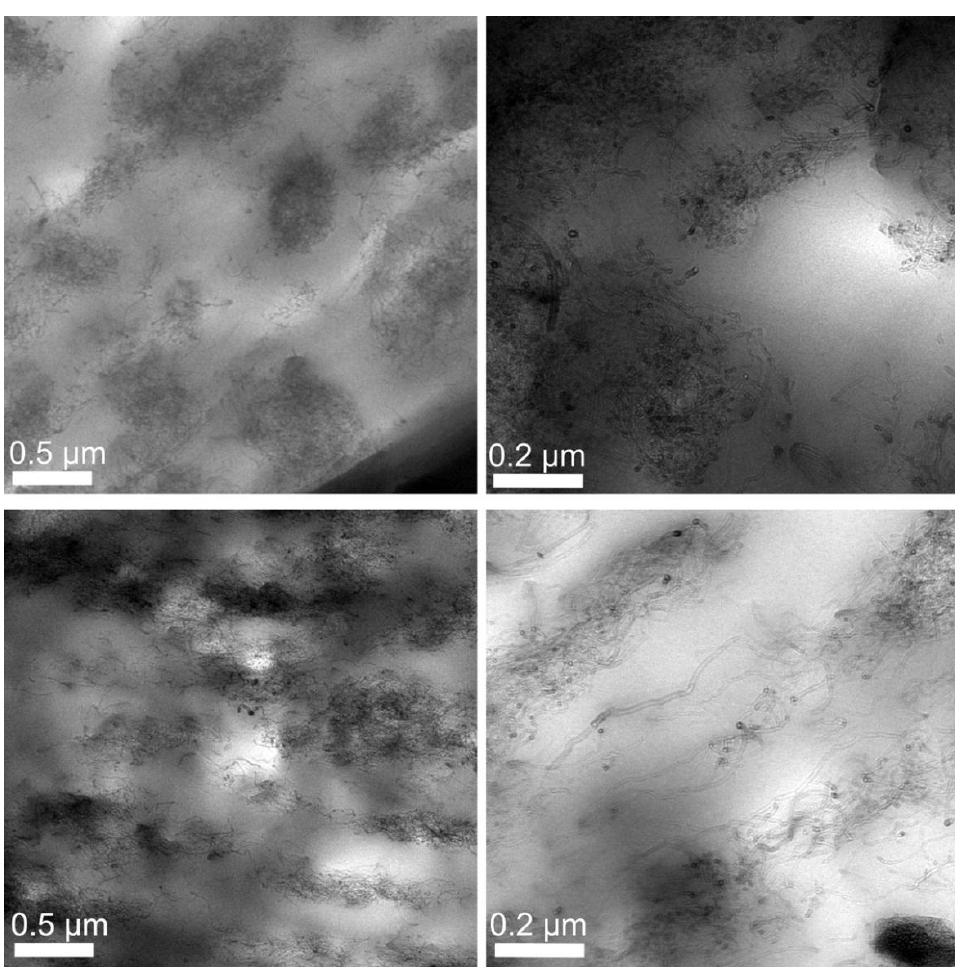
Figure 13. TEM images showing the CNT percolation network at different resolutions and draw ratios. Top: No Drawing applied. Bottom: Draw ratio